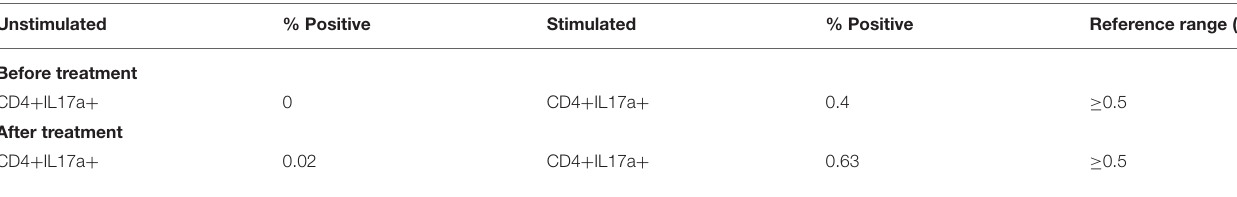
TABLE 2 | Treatment with dupilumab led to normalization of CD4T cell induction of intracellular IL-17 following stimulation. Unstimulated % Positive Stimulated % Positive Reference range (%) Before treatment After